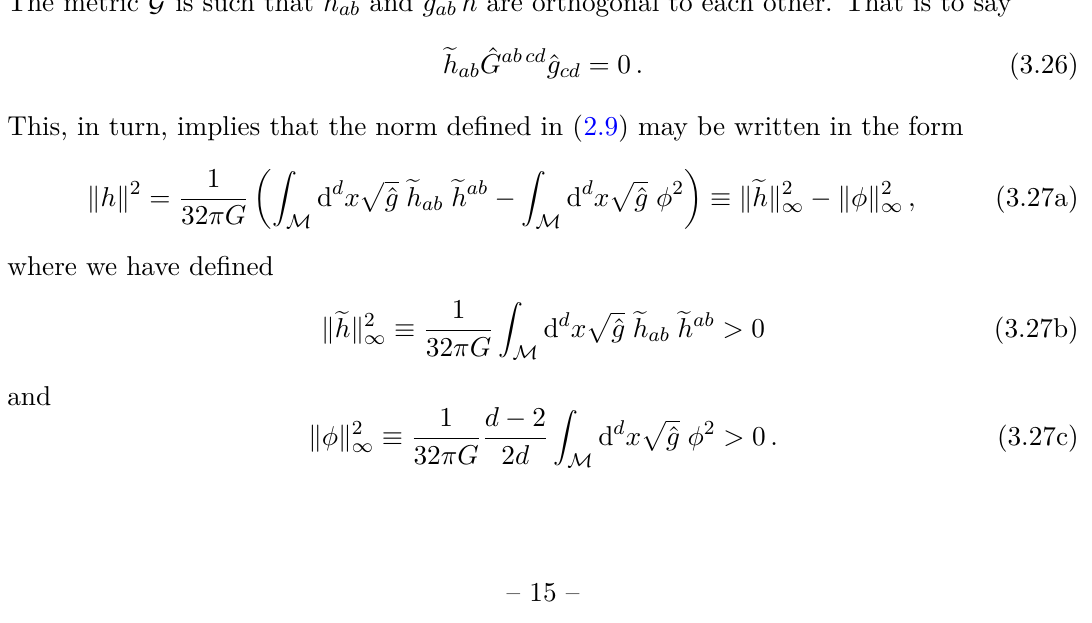
Figure 1 . The dimensionless lowest lying mode e λ ≡ λ r 2 (left panel) and d = 5 (right panel). The black line in each of the plots corresponds to the locus in moduli space where e λ = 0 and it coincides precisely with eq. (B.11). To aid visualisation we also plot the plane e λ = 0 in